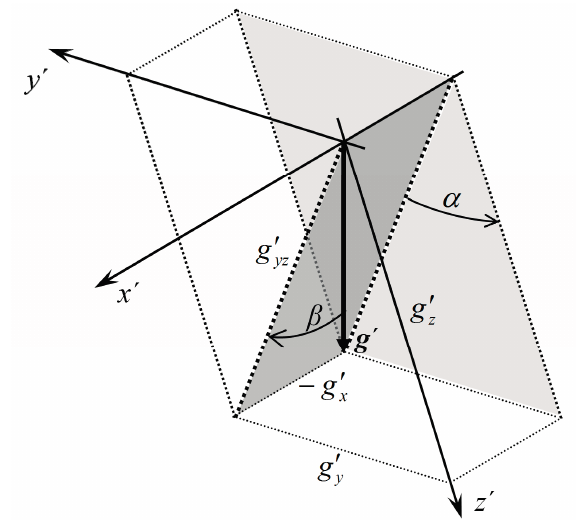
Figure 14. Roll and pitch calculation from measured gravity acceleration. Object pitches up and rolls right (axis x' points forward). The vector g ' defines vertical